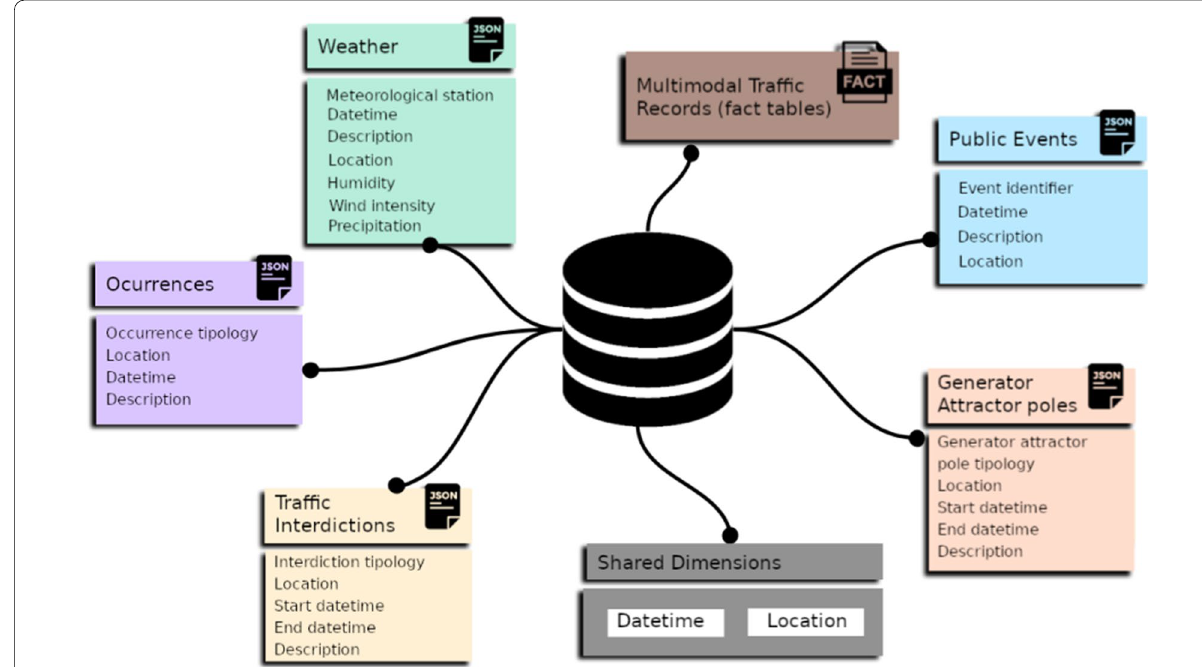
Fig. 4 Multi-dimensional schema where each context data source is stored in a dedicated dimension, and traffic records are stored in fact tables. Associations between a fact entry and the corresponding entries for each context dimension are efficiently established by assessing the location (trajectory) and timestamp (time interval) of a traffic record against the spatiotemporal footprint of a context entry (e.g. public event, weather record,